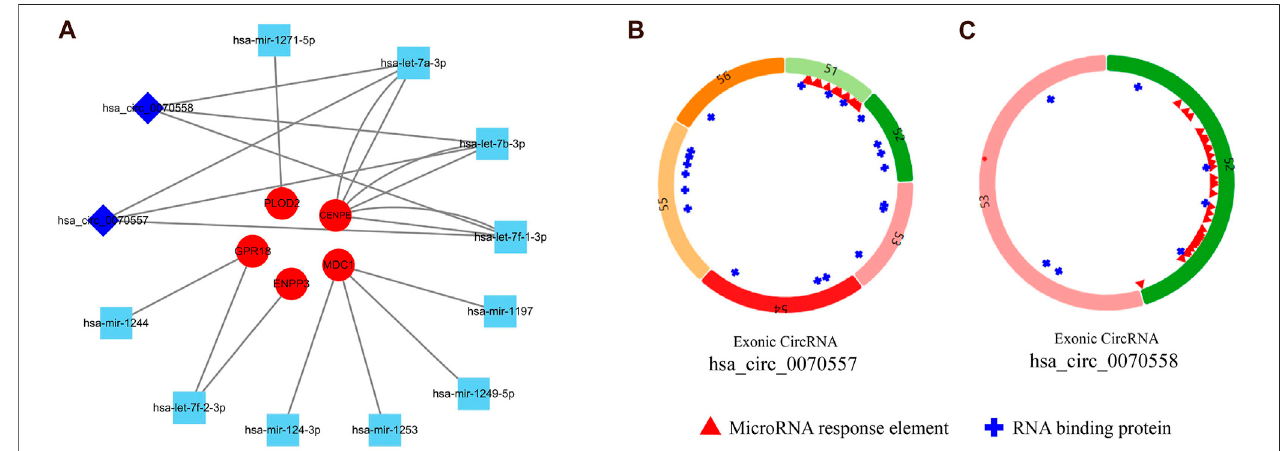
FIGURE 5| To investigate the regulatory mechanism ofsynovial sarcoma, weconstructed acirculatoryRNA-microRNA-messengerRNA (circRNA-miRNA-mRNA) (competing endogenous RNA) network using circRNA-miRNA pairs and miRNA-mRNA pairs with Cytoscape 3.7.2. (A) Squares represent circRNA, diamonds represent miRNA, and circles represent mRNA. (B) Basic information regarding two circRNAs (has_circ_0070557 and